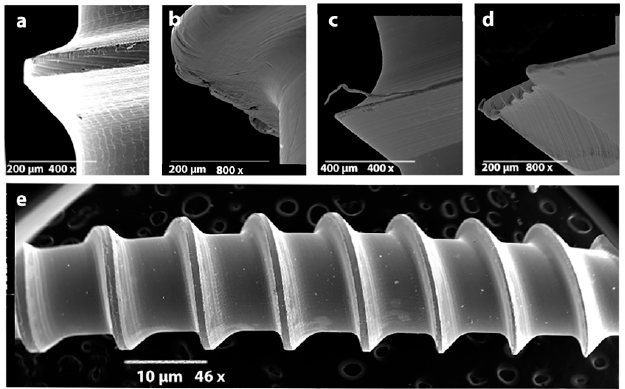
Figure 1. ( a–d ) : Surface irregularities and metal spikes as viewed by the Scanning Electron Microscope (SEM). From left to right: ( a ) Dual Top, ( b ) Spider®, ( c ) Microdent, ( d ) Absoanchor®. ( e ) : Count of contaminating particles (white dots) on the body of the visible side of an orthodontic mini-implant (OMI).